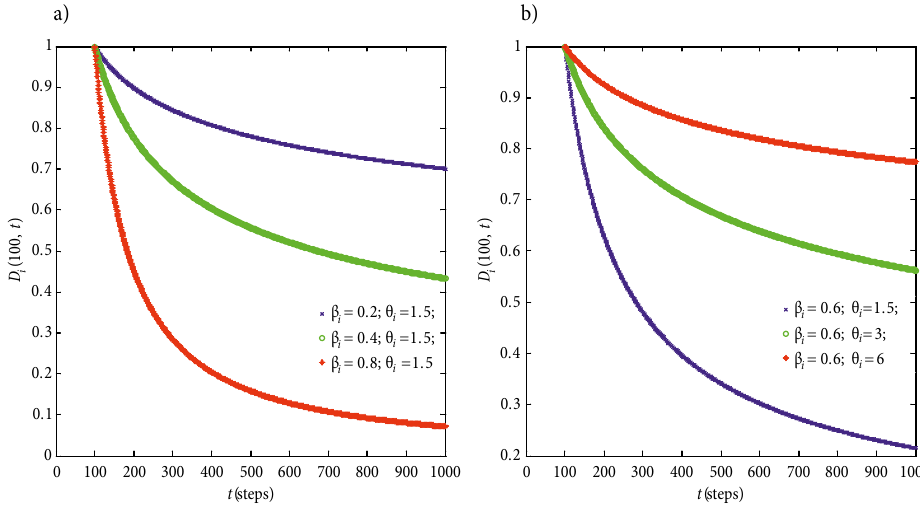
Fig. 1. The survival probability D and has not been deleted until time step t as a function of b